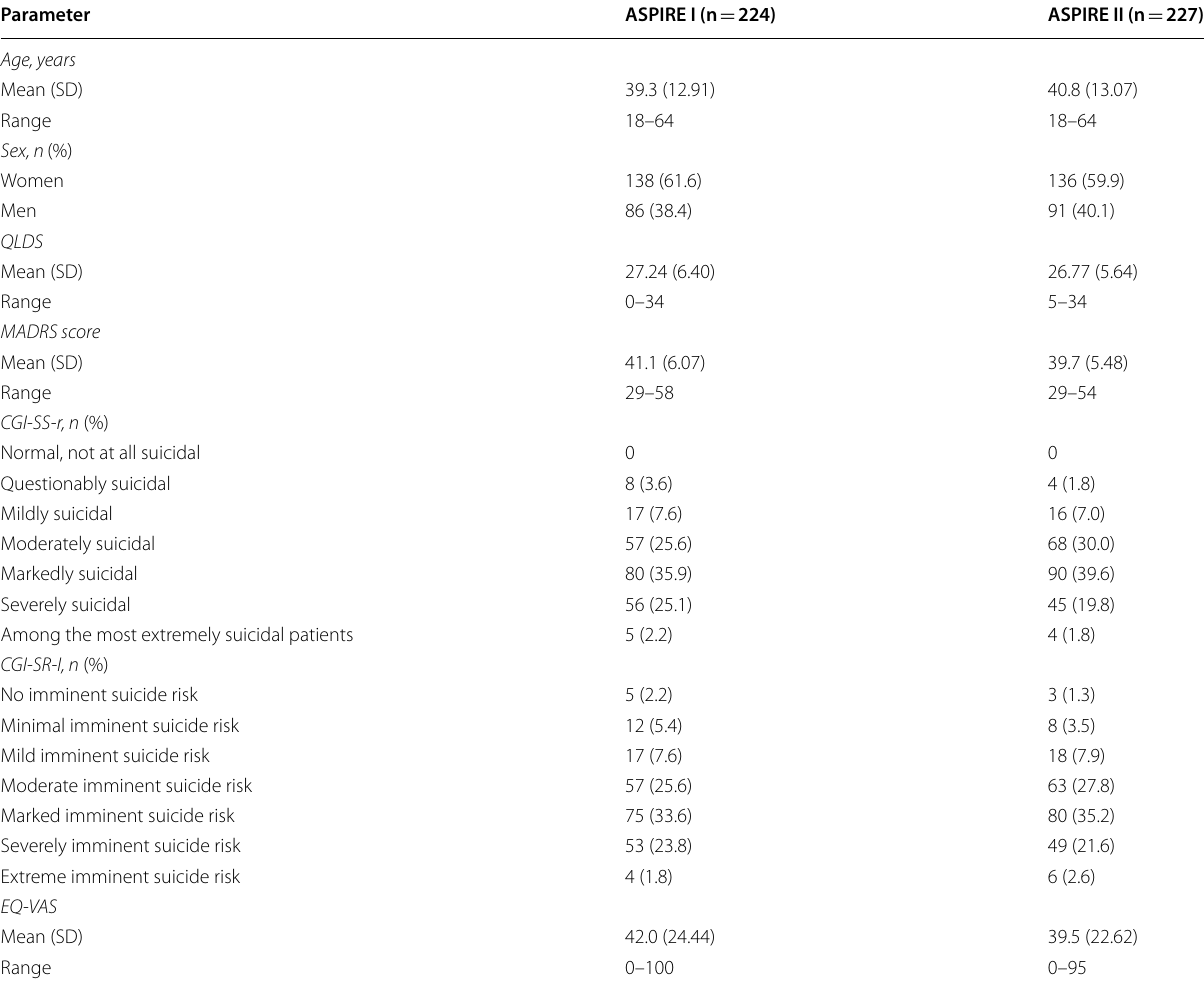
Table 2 Summary of demographics and anchor variables at